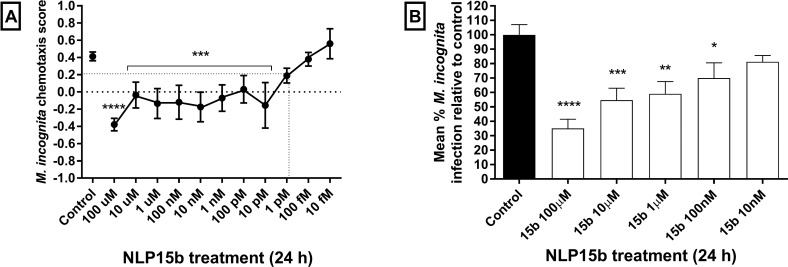
Mi- NLP-15b potently inhibits the chemotaxis and infectivity of Meloidogyne incognita.(A) Serial dilutions of Mi-NLP-15b indicate that J2 chemotaxis is inhibited by low picomolar concentrations. (B) Mi-NLP-15b significantly reduced J2 invasion levels at nanomolar concentrations. Data shown represent the mean±SEM. *, P<0.05; **, P<0.01; ***, P<0.001; ****, P<0.0001 (One-Way ANOVA & Fisher’s LSD; Graphpad Prism 6).